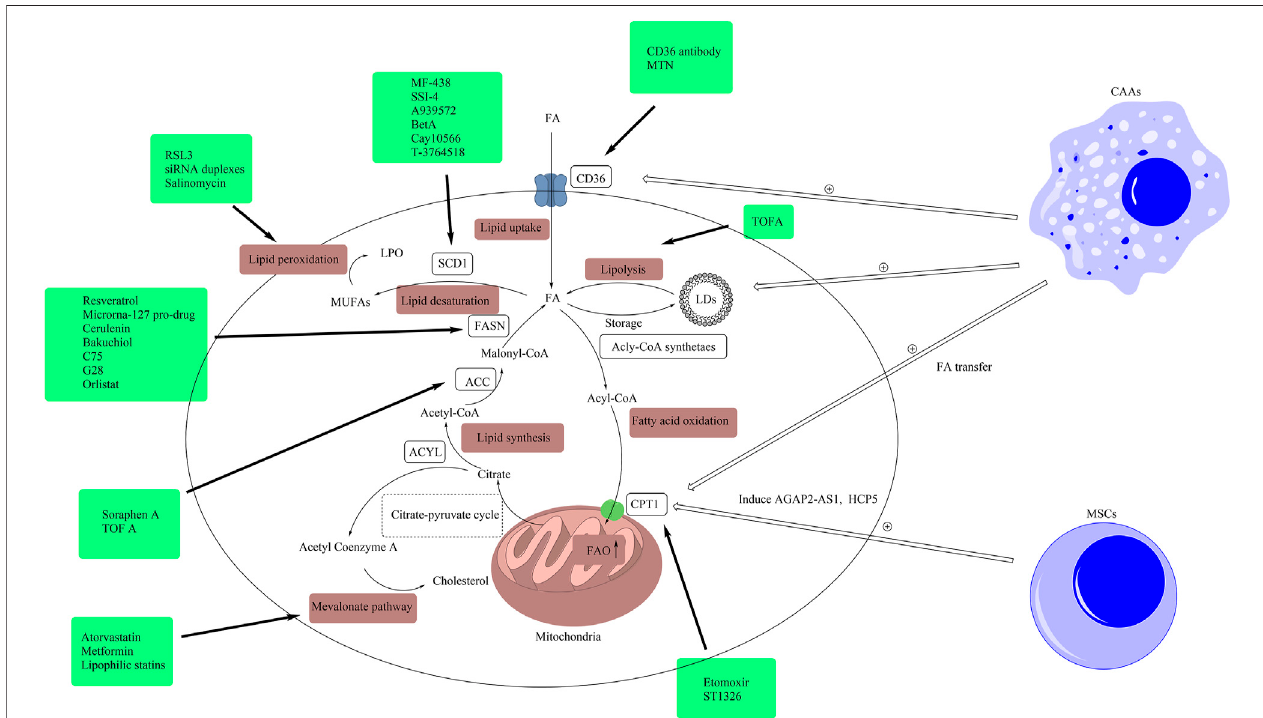
FIGURE3| Drugstargeting lipidmetabolism.Inthis fi gure,wepresented related drugs, whichwerelisted in Table 1 ,intheboxesand linkedthem tothetargetsof lipidmetabolismincludinglipiduptake,lipolysis,fattyacidoxidation,lipidsynthesis,lipiddesaturation,themevalonatepathwayandlipidperoxidation.(ACLY,ATPcitrate lyase; ACC, acetyl-CoA carboxylase; CAA, cancer-associated adipocytes; FA, fatty acid; FAO, fatty acid oxidation; FASN, fatty acid synthase; CD36, cluster of differentiation36;LD,lipiddroplet;CPT1,carnitinepalmitoyltransferase-1;MUFA,monounsaturatedfattyacid;MSC,mesenchymalstemcell;SCD1,stearoyl-CoA desaturase 1; TME, tumor microenvironment; LPO, lethal lipid peroxides).